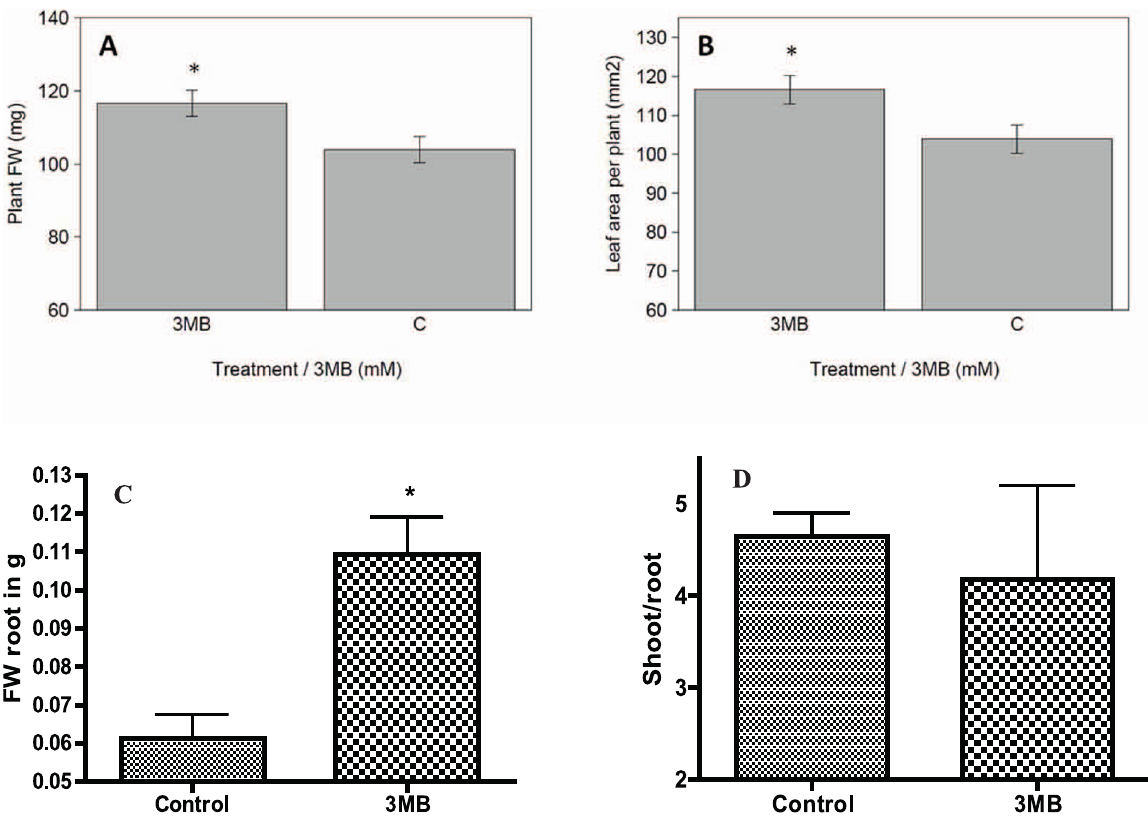
Figure 1. PARP inhibition enhances growth and biomass in control conditions. Hydroponically grown plants were analyzed in respect to leaf area and biomass. 18 plants per experiment and treatment were analyzed, repeated in four experiments and the average leaf area of plants at day 26 (A) or shoot biomass (B), root biomass (C) and the shoot to root ration (D) of plants harvested day 30 is shown. Significant differences (P , 0.05) between treated (0.2 mM 3MB) and untreated (125 m l DMSO) plants is indicated by an asterisk.